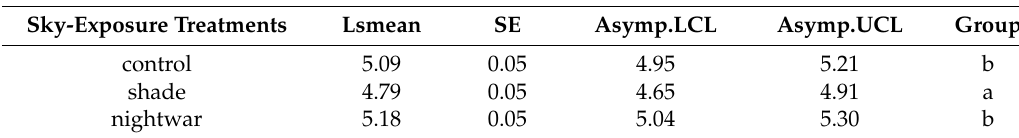
Table A3. Model estimates (lsmean = biomass (mg), log scale) and Tukey-adjusted comparisons (snow:sky exposure) averaged over sky-exposure treatments and species, in the GLM assessing the effect of snow and sky-exposure treatments on biomass for seedlings planted in autumn 2013, assessed in 2014, near the treeline in the French Alps. SE = Standard error, Asymp.LCL and Asymp.UCL = asymptotic lower and upper control limits. Groups indicate significantly different treatment